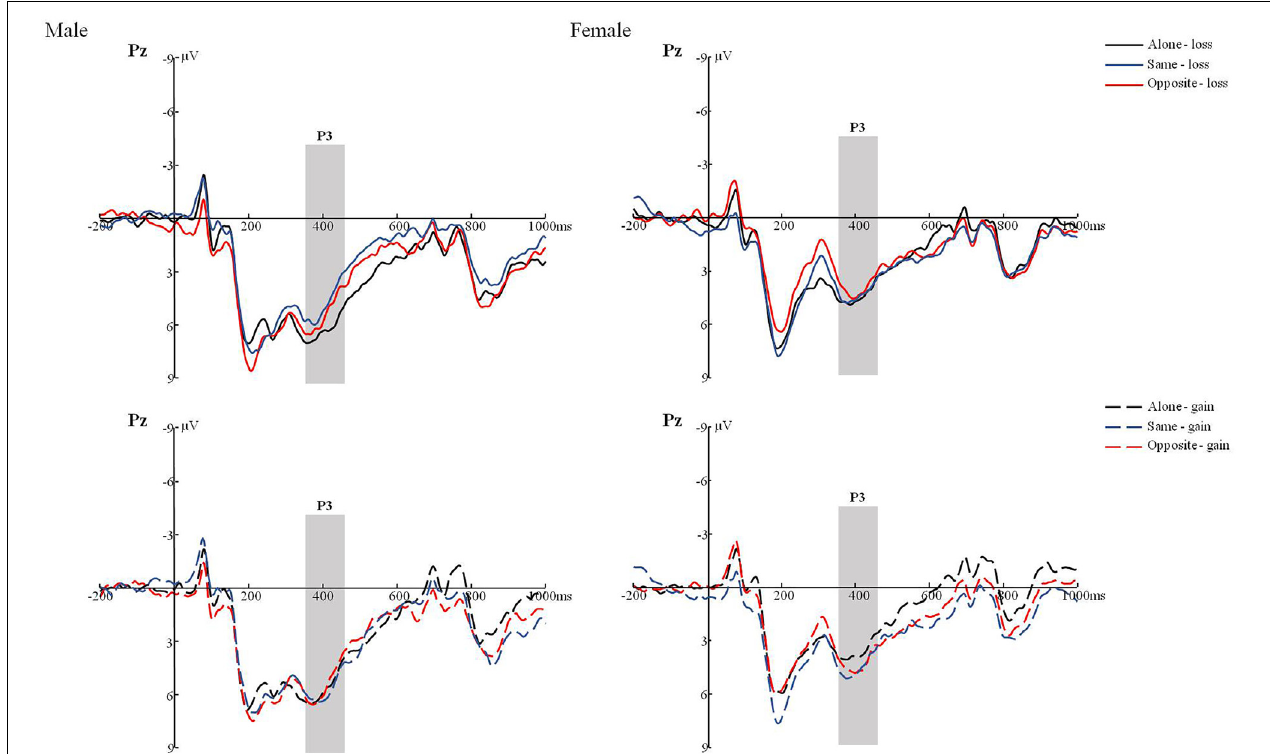
FIGURE 4 | The P3 of male/female under the condition of different joint task in loss/win.